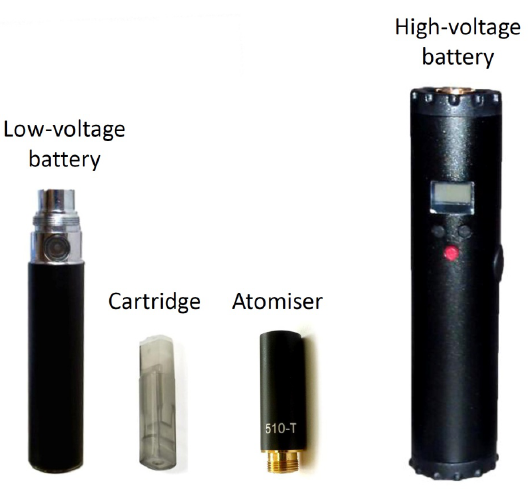
Figure 1. Electronic cigarette devices used in this study. The low voltage device delivered 3.7 volts to the atomiser while the high-voltage device integrates an electronic circuit by which the voltage applied to the atomiser can be adjusted. For the high-voltage experiments it was set to 4.7 volts. The cartridge is the part where liquid is stored, while the atomiser is the part where the resistance and wick are placed and evaporation of the liquid takes